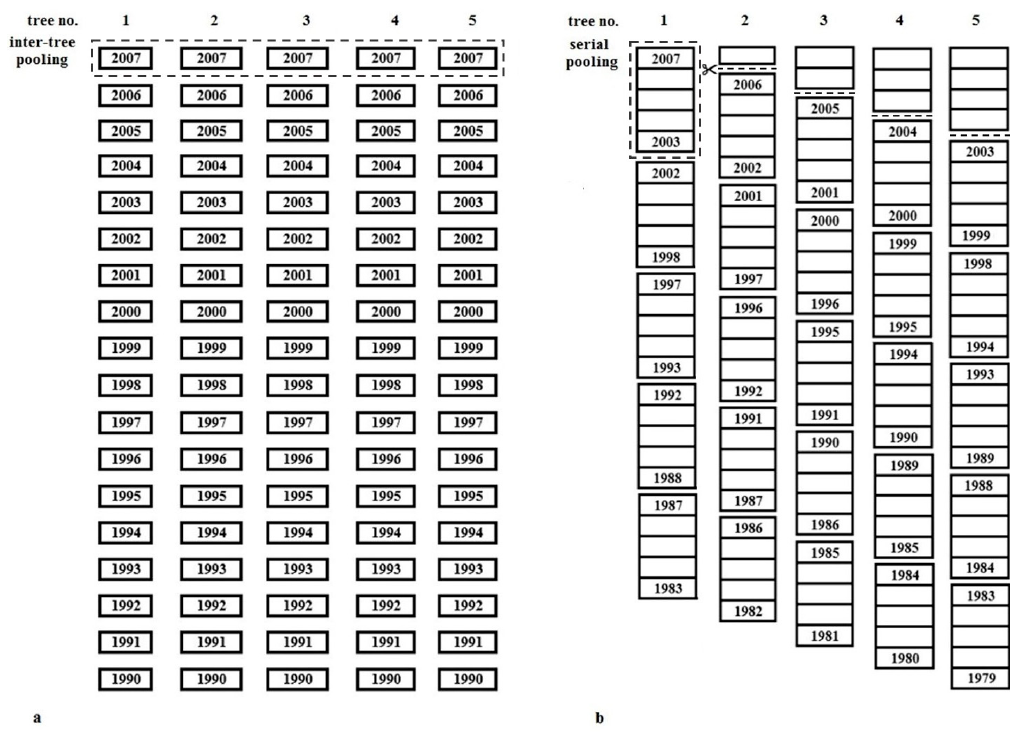
Figure 2. Schematic of cutting and pooling the trees rings in two ways of ( a ) inter-tree pooling ( b ) serial pooling of 5-year blocks shifted for one year between individual trees.